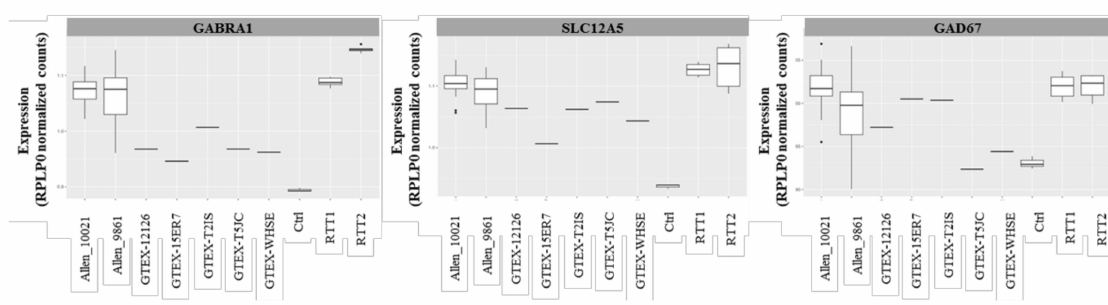
Figure 4. GABAergic pathways genes expression assessment in brain patients by RNAseq. Comparison of the GABA ionotropic receptors subunits GABRA1 , and KCC2 and GAD67 genes between the patients (RTT 1 and RTT 2), the intra-assay control (Ctrl), and publicly available controls, showing a tendency to increase in the Rett patients. The results were normalized by RPLP0